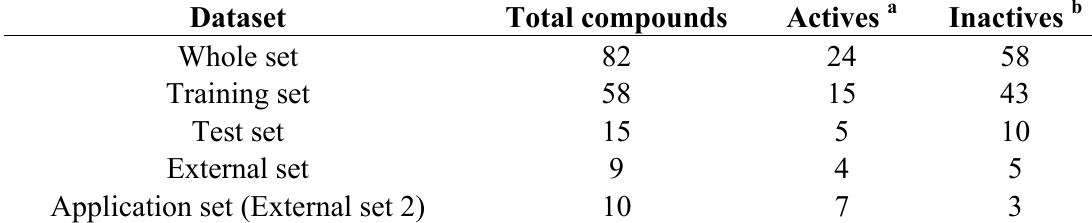
Table 7. BCPs datasets